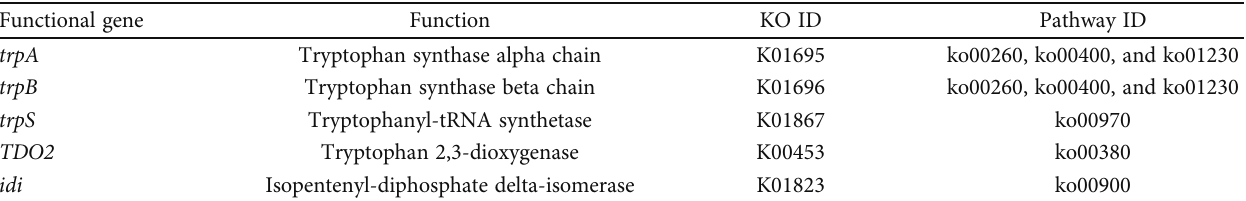
Table 3: Functional genes and metabolic pathways related to auxin synthesis in Bacillus megaterium. Functional